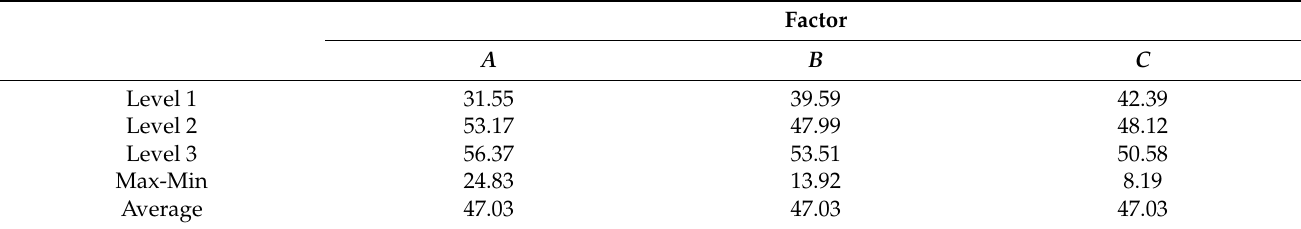
Table 9. Average S/N ratio by factor levels